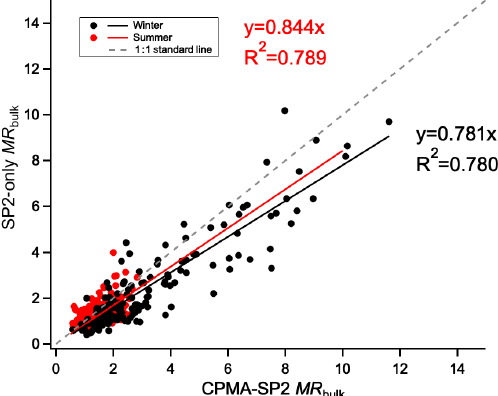
Figure 6. The comparison between bulk mass ratio (MR bulk ) from the CPMA–SP2 method and from the SP2-only